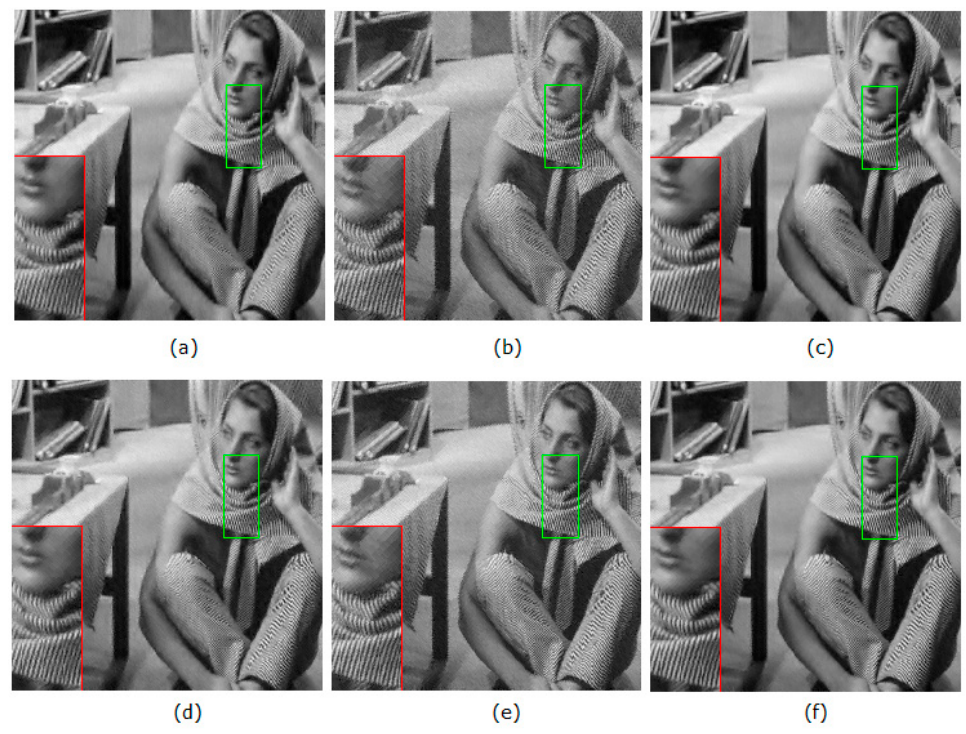
Figure 5. The clean images and the corresponding single-look speckle (𝜎 = 0.08) synthetic images. ( a ) Clean grayscale image ( b ) Speckled grayscale image (16.52 dB); ( c ) Clean color image; ( d )Speck- led color image (17.89 dB).